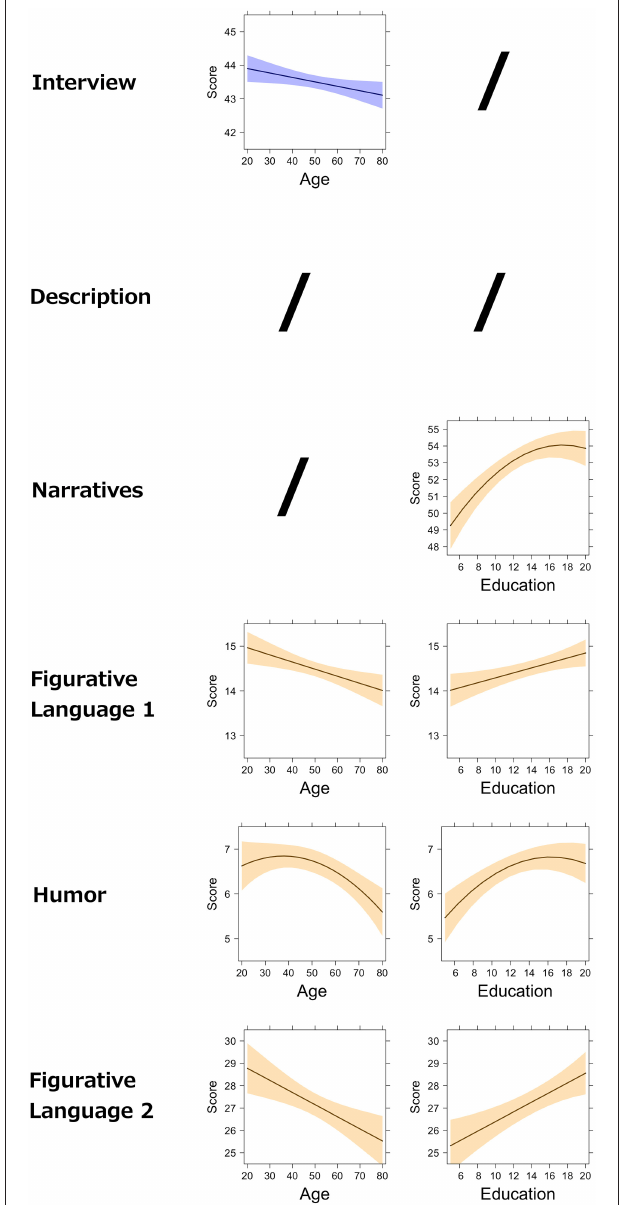
FIGURE 2 | Effect of demographic variables on APACS tasks. The figure shows the partial effects of age and education on APACS tasks, as estimated by regression analysis. The figure is an array displaying the APACS tasks (first column) and the effect of age (second column) and education (third column). A slash (“/”) indicates that the effect was not significant in the regression analysis. The black line in each plot represents the predicted score at the APACS task. The colored bands around the line represent point-wise confidence bands around the prediction. Light blue is used for the tasks that compose the Pragmatic Production score. Light orange is used for the tasks that compose the Pragmatic Comprehension score.